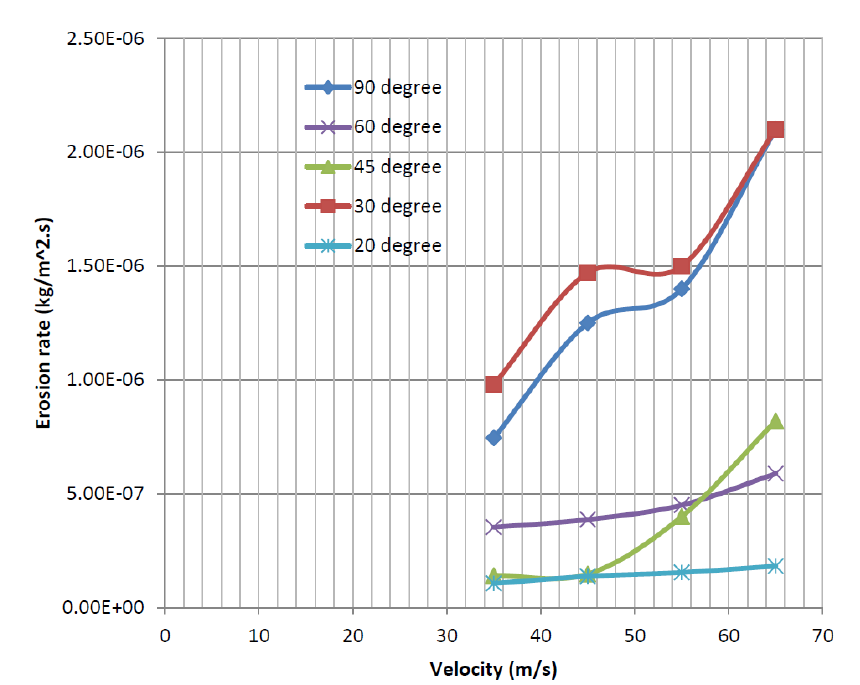
Figure 5: Erosion rate vs. wind velocity curve for glass fibre resin at different angle of